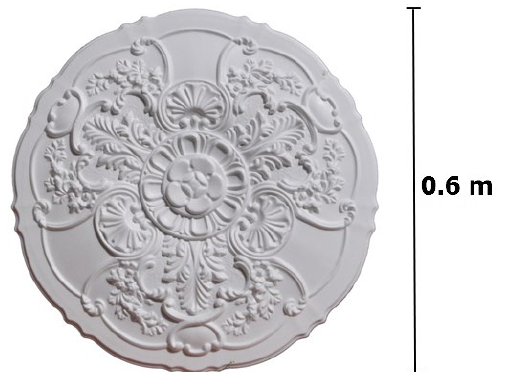
Figure 6. Test object made from styrofoa m - example of a architectural detail The model was scanned from 3 different distances: 5 m ( fig. 7), 10 m (fig. 8) and 20 m (f ig. 9). For each distance, scanning was performed at three resolution settings: 1/1 (A), 1/2 (B) and 1/4 (C). Resolutions, according to the manufacturer's information, should correspond to the average distance between points: 1.534 mm (A), 3.068 mm (B) and 6.136 mm (B) during scanning from a distance of 10m. The final point clouds are shown in the figures below. Each of the point clouds is presented in a grayscale of intensity on a black background. In a situation where the cloud is more dense, the figure is "lighter" ( fig. 7 A). When the data sets are more rare, the more background can be seen, making the picture darker (fig. 7 C). The same